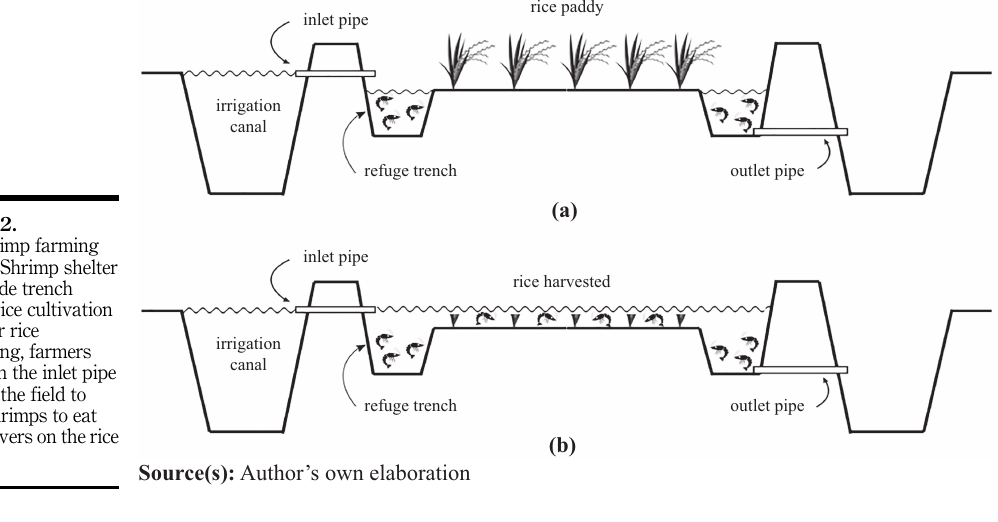
Figure 3. The application of rice- shrimp farming in the Mekong Delta included the current application in Ben Tre province (mixed culture). Periods of shrimp cultureareindicatedby solid arrows, while periods of rice cultivation are indicated by a dotted arrow.Intheintegrated culture, the short and heavy dotted arrow indicates the nursing